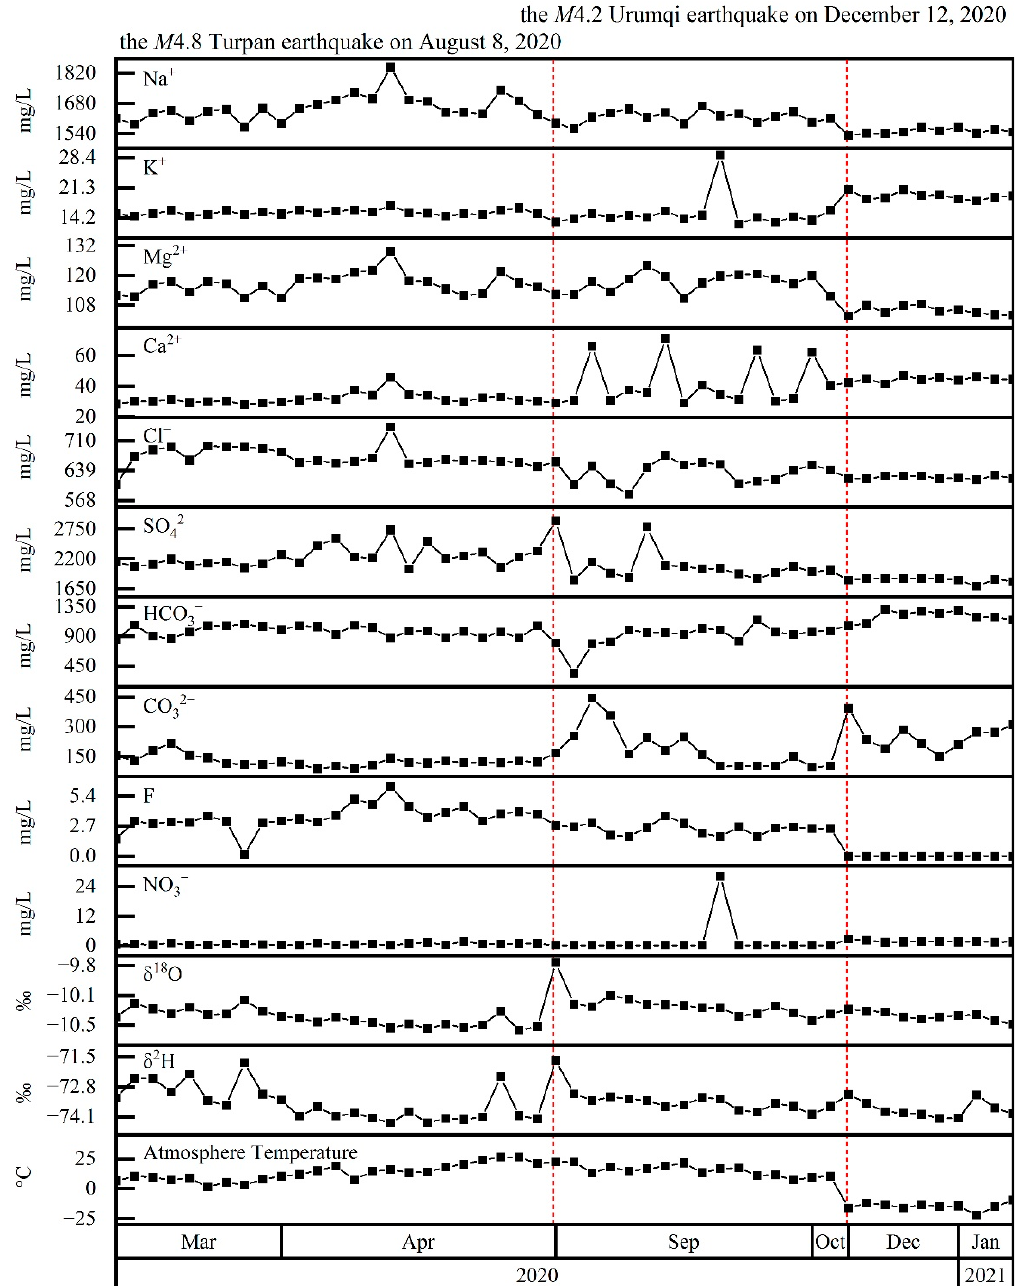
Figure 2. Time series of Spring 04 major ion concentrations (Na + , K + , Mg 2+ , Ca 2+ , Cl − , SO 42 − , HCO 3 − , CO 32 − , F − , and NO 3 − ), stable isotopes ( δ 2 H, δ 18 O), and atmospheric temperature. Red-dashed lines mark the occurrence of potentially significant earthquakes within the study area.